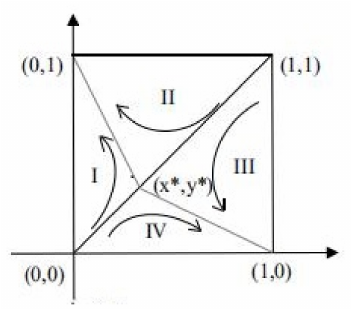
Figure 6. Phase diagram of the evolutionary game in case